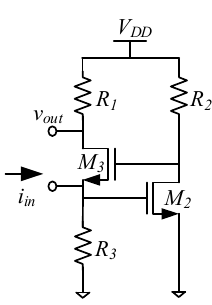
Figure 28 . Regulated cascode trans-impedance amplifier stage. Figure 28. Regulated cascode trans-impedance amplifier stage.